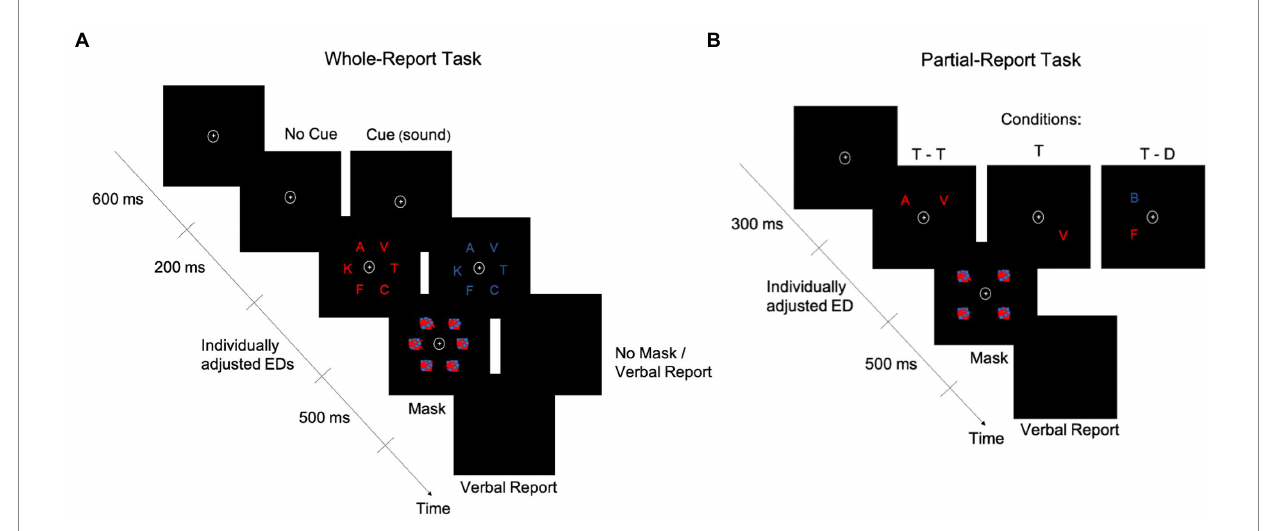
FIGURE 1 Schematics of the whole-report and partial-report tasks. A whole-report (A) and a partial-report (B) task trial are represented over time. D, distractor; ED, exposure duration; T,